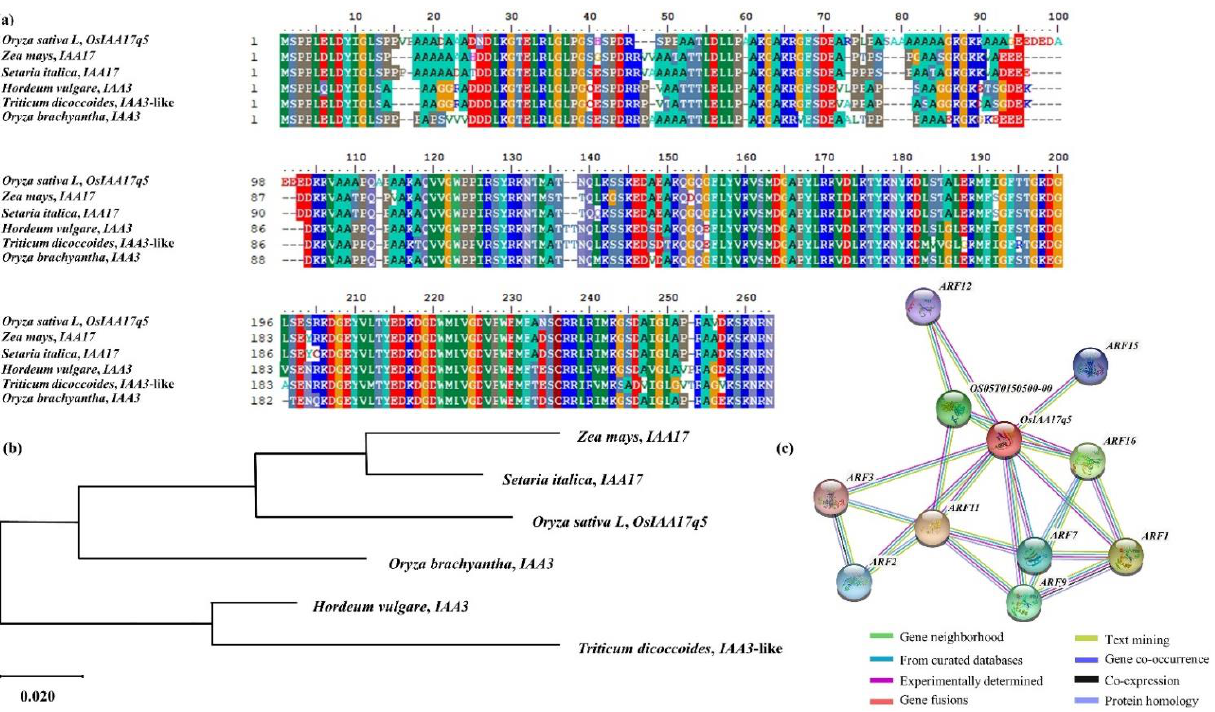
Figure 8. Sequence analysis of OsIAA17q5 . ( a ) Comparison of the protein sequences of OsIAA17q5 homologous genes; a very high similarity was found in Zea mays , Setaria italica , Hordeum vulgare , Triticum dicoccoides , and Oryza brachyantha . ( b ) Phylogenetic tree used to analyze OsIAA17q5 and its homologous genes. The phylogenetic tree was constructed with 1000 bootstrap replicates using the parsimony method. ( c ) Protein interaction of OsIAA17q5 . The gene interacts with OS05T0150500-00, ARF1, ARF2, ARF3, ARF7, ARF9, ARF11, ARF12, ARF15, and ARF16.